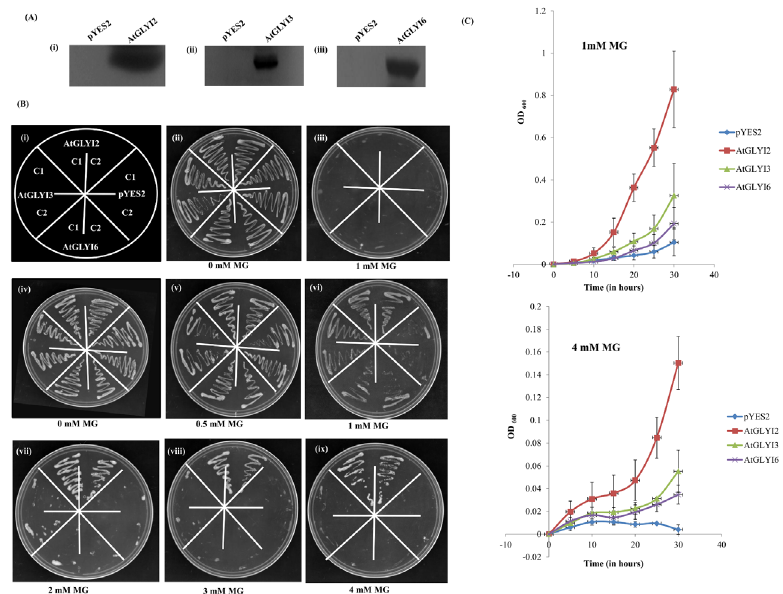
Fig 5. Functional complementation assay using the yeast Δ GLO1 mutant. The Saccharomyces cerevisiae GLYI mutant cells were transformed with constructs pYES2- AtGLYI2 , pYES2- AtGLYI3 , pYES2- AtGLYI6 and empty vector pYES2. (A) Western blot depicting expression of AtGLYI2, AtGLYI3 and AtGLYI6 proteins in the total protein extract of yeast cells. Western blotting was done using protein specific antibodies. (B) The transformed cells were grown on solid Ura- SD media with various supplements to check for stress tolerance of yeast cells transformed with AtGLYI genes (i) Pictorial depiction of various strains used (C1 and C2 refers to the two different colonies used). (ii) Medium supplemented with 20% glucose; (iii) Medium supplemented with 20% glucose and 1 mM MG; (iv) Medium supplemented with 20% galactose; (v)